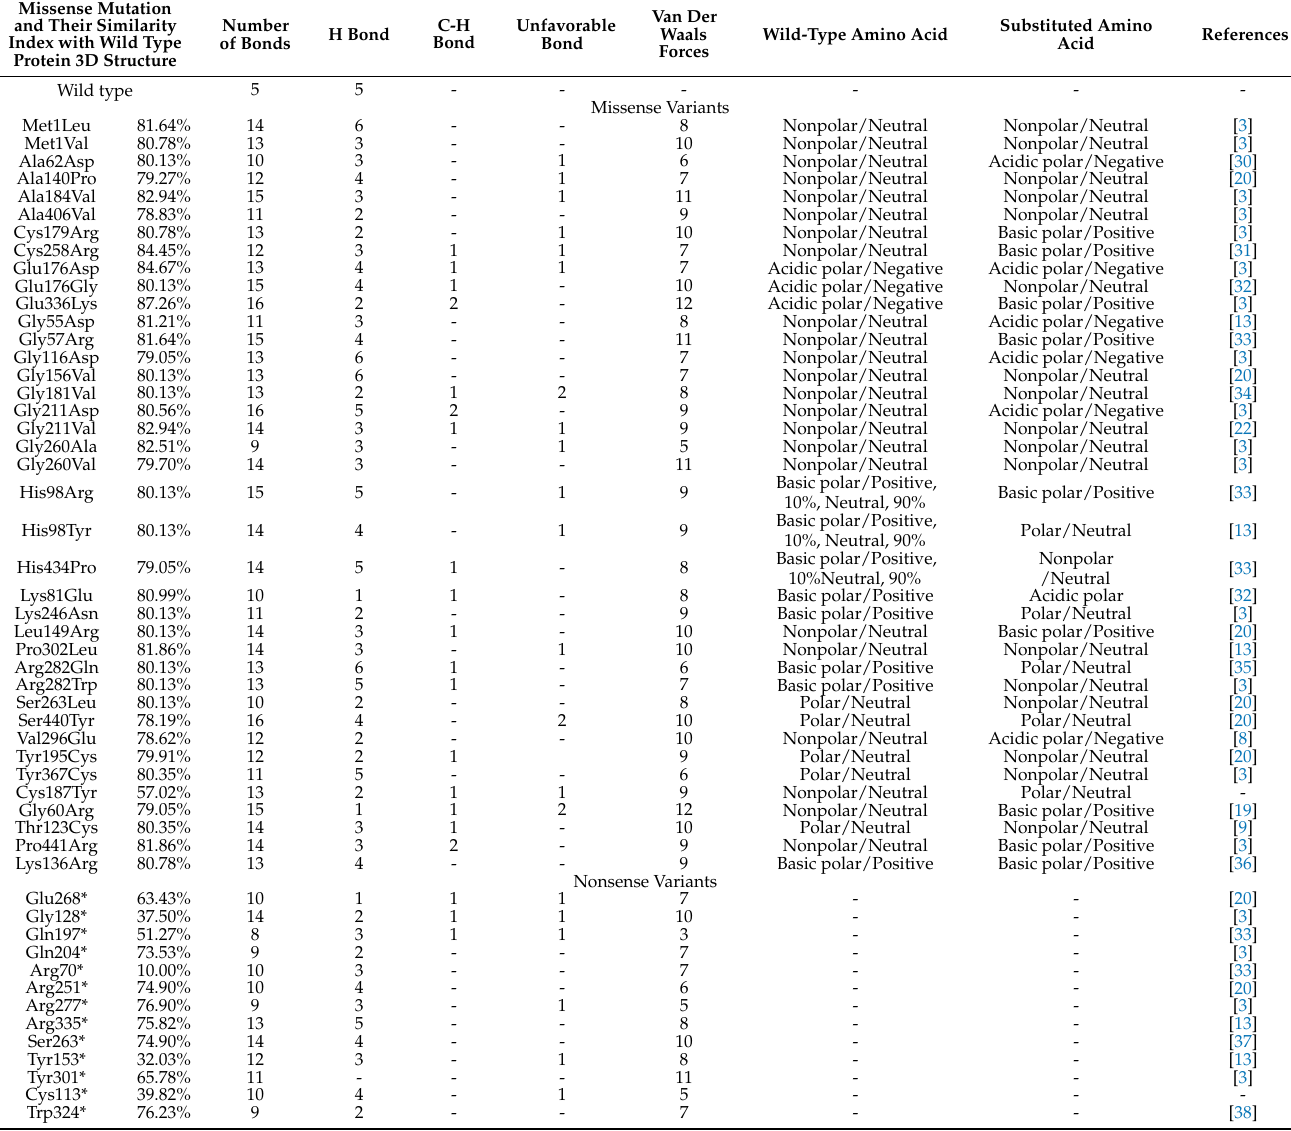
Table 1. Summary of the nature of amino acid substitution and the type and number of bonds between the mutant L2HGDH and substrate